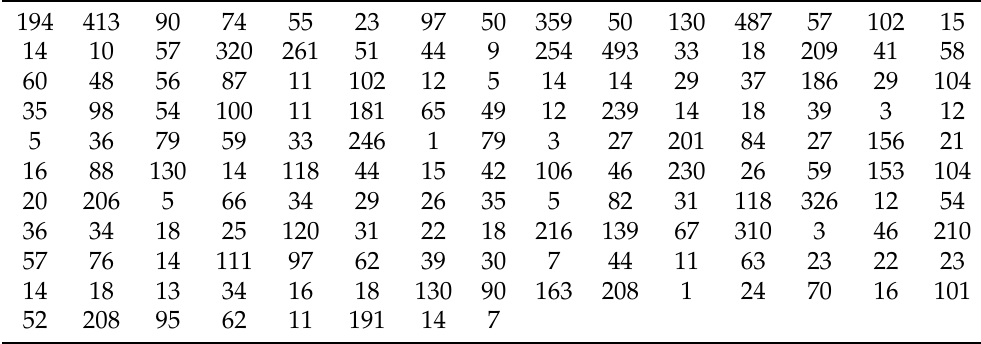
Table 5. Data on the successive failures for the air conditioning system of each member in a fleet of 13 Boeing 720 jet air planes.